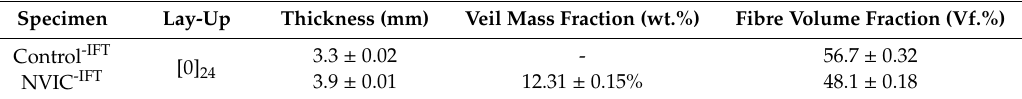
Table 4. Characteristics of specimens for interlaminar toughness study.